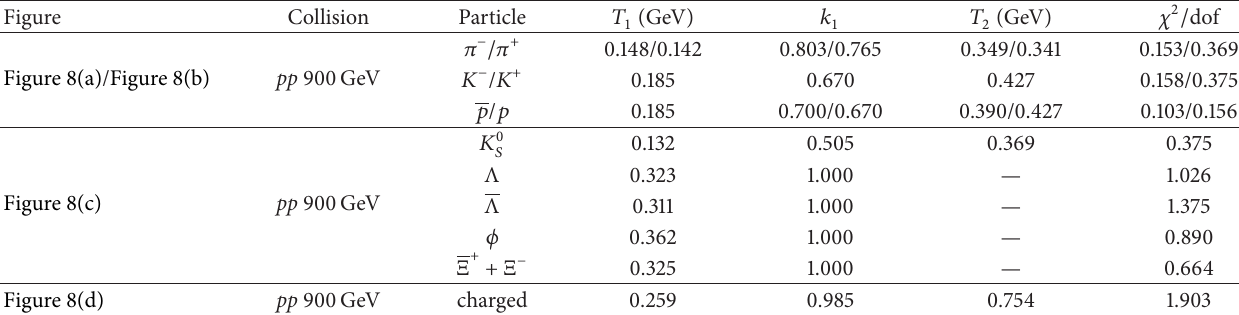
Table 8: Parameter values corresponding to the curves in Figure 8. Figure Collision